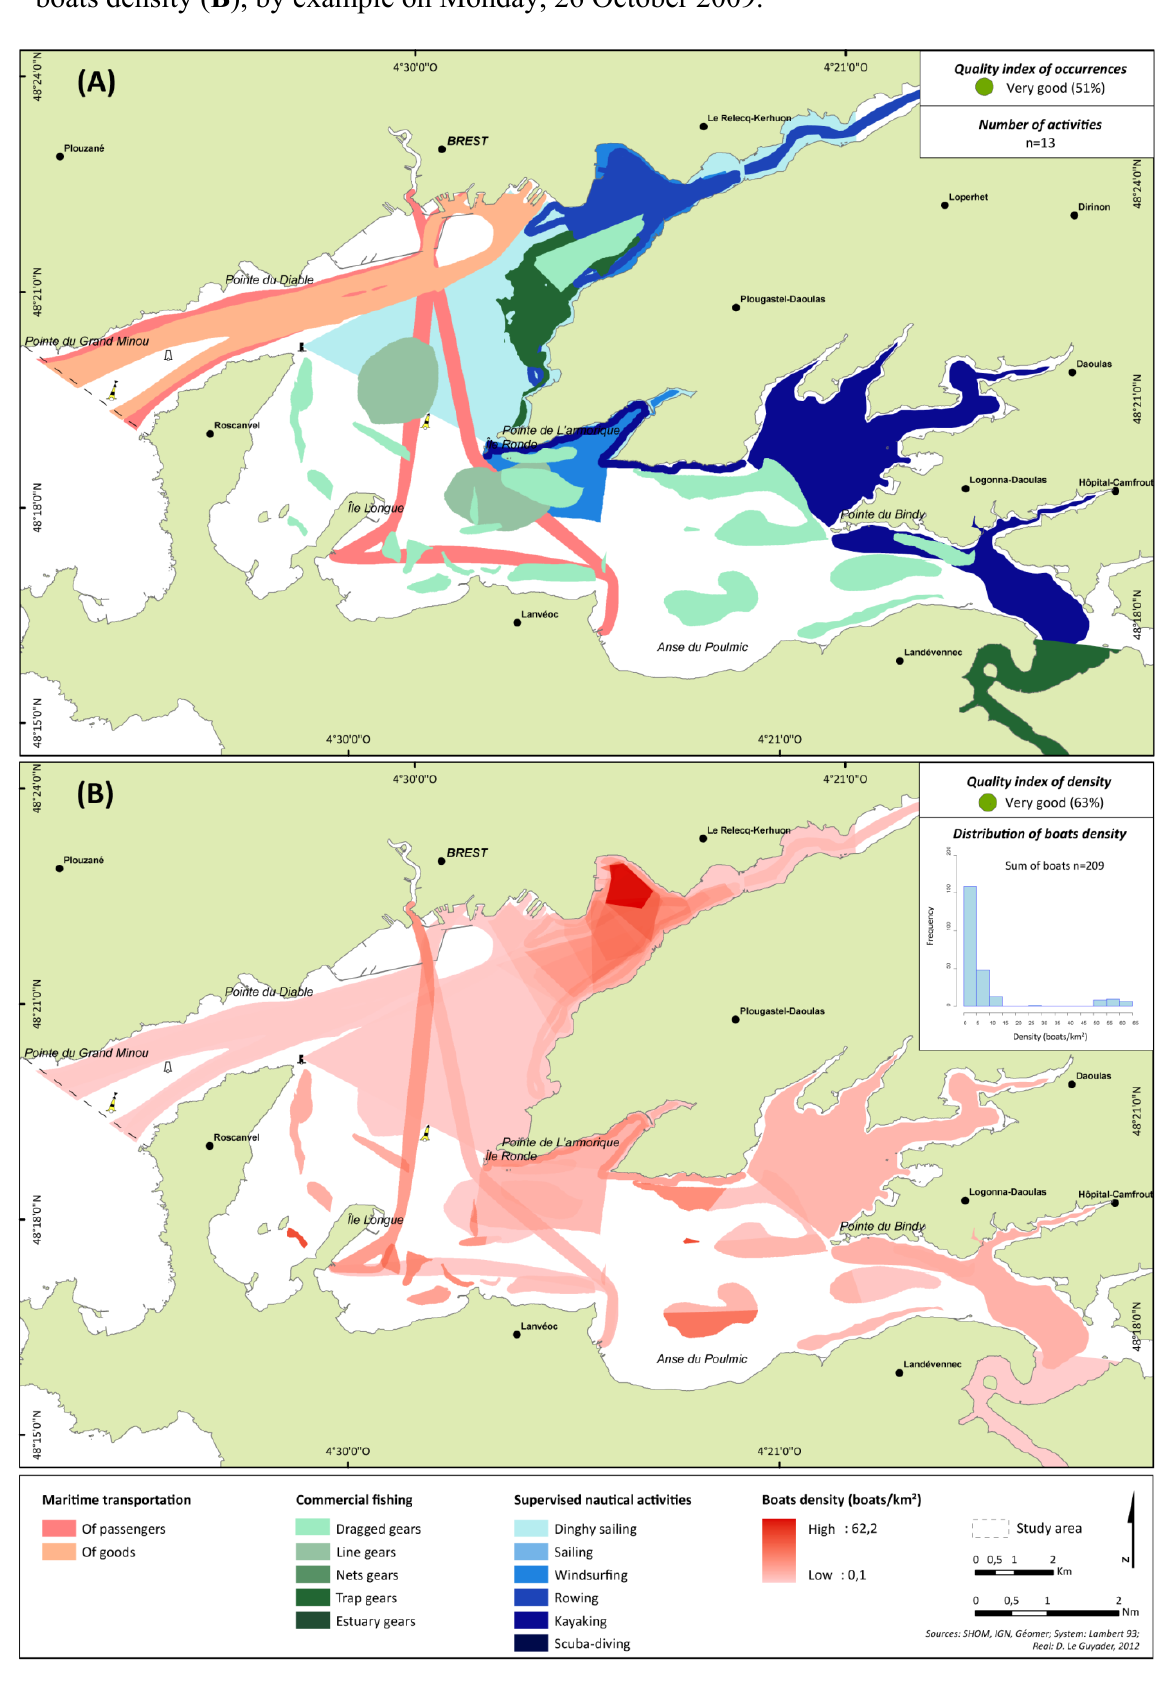
Figure 5. Activity zones for supervised maritime activities in the Bay of Brest ( A ) and boats density ( B ), by example on Monday, 26 October